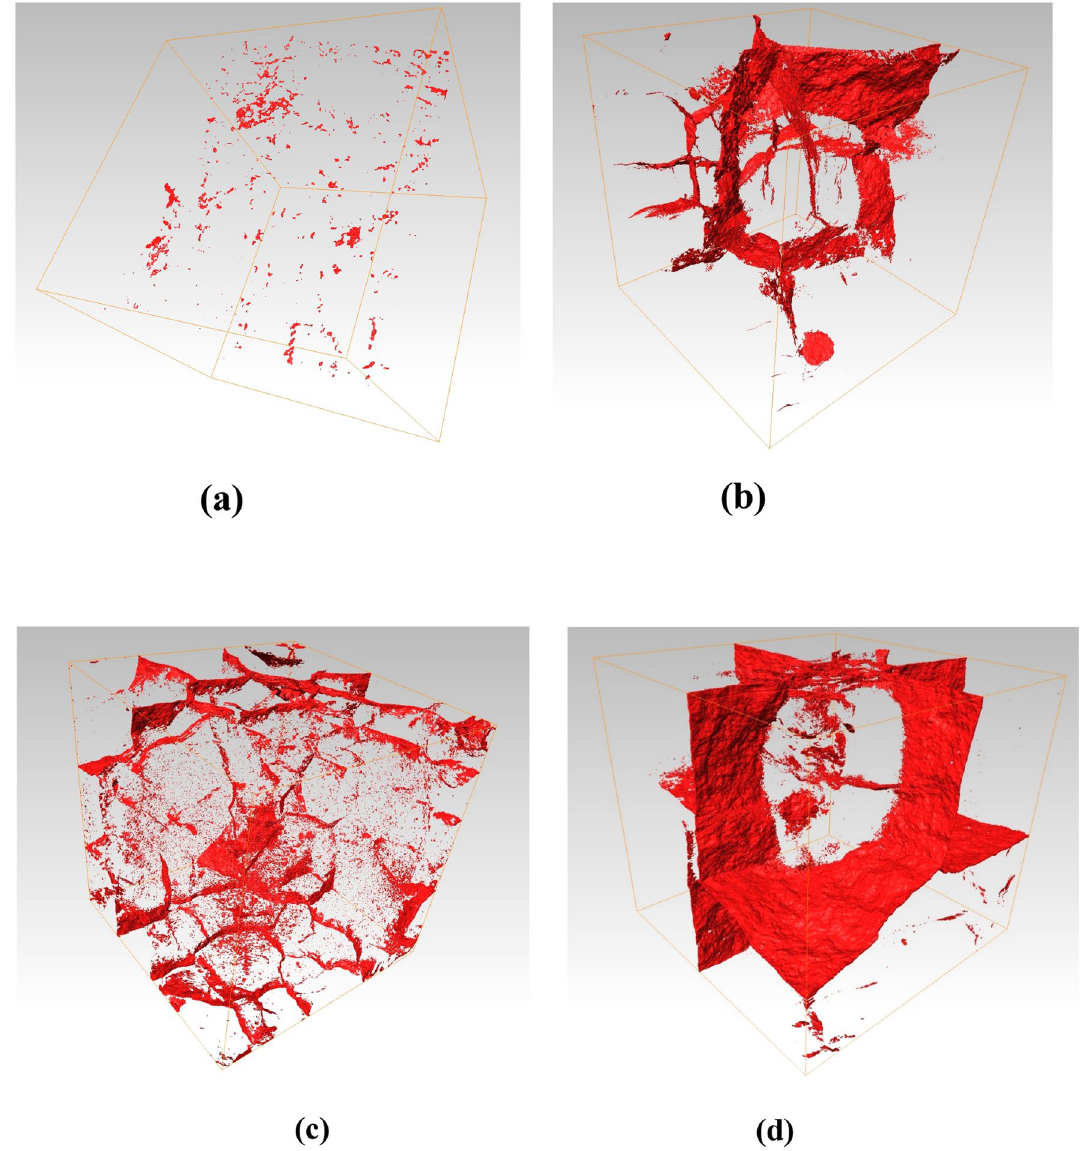
Figure 7. The spatial distribution of pores/cracks in the limestone sample after high-temperature treatment: ( a ) 700 °C; ( b ) 800 °C; ( c ) 900 °C; ( d ) 1000